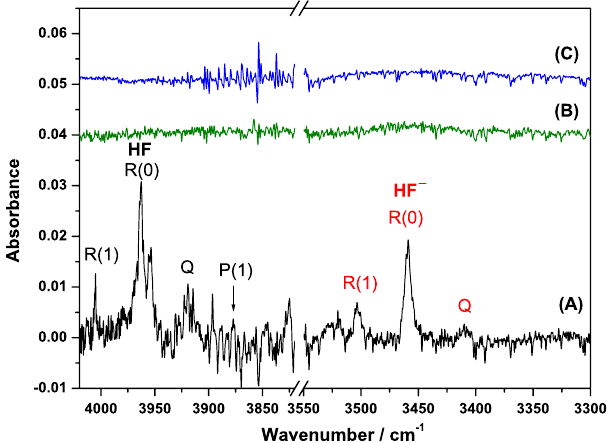
Figure 1. Partial IR spectra of electron-bombarded (2000 eV, 0.3 mA) matrix samples at 10 K. ( A ) CH 3 F/Ar (1/500), ( B ) CH 4 /Ar (1/500), and ( C ) Ar. The ro-vibrational transitions of the observed bands are